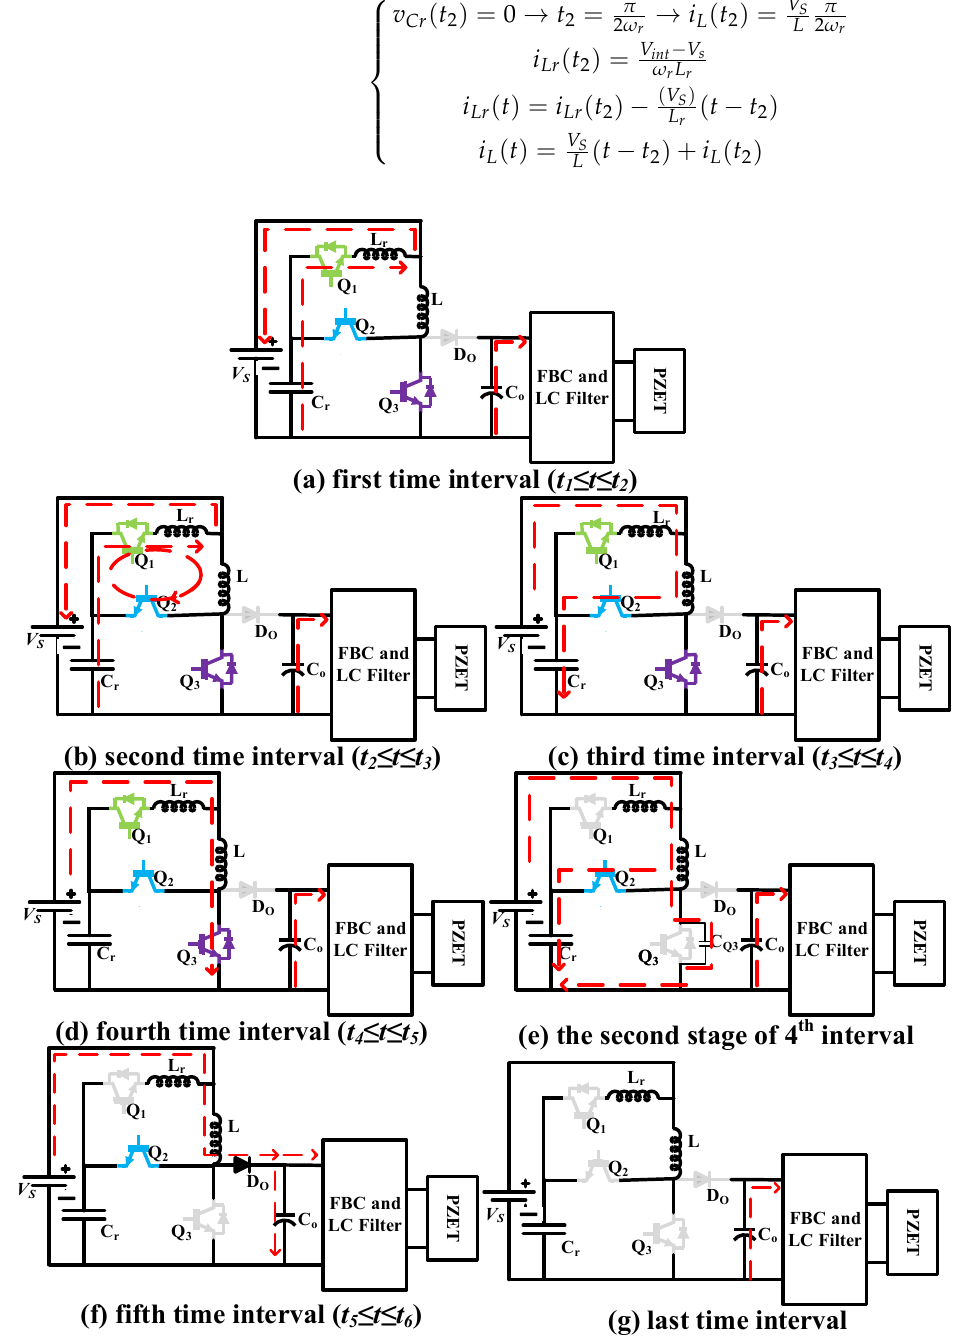
Figure 3. Circuit configurations of the proposed converter in different operation modes. The dashed line shows the current paths in each time interval. The green, blue, and purple are used to distinguish the Q 1 , Q 2 , and Q 3 from each other. Any gray switch shows that the switch is off in the mentioned time interval.